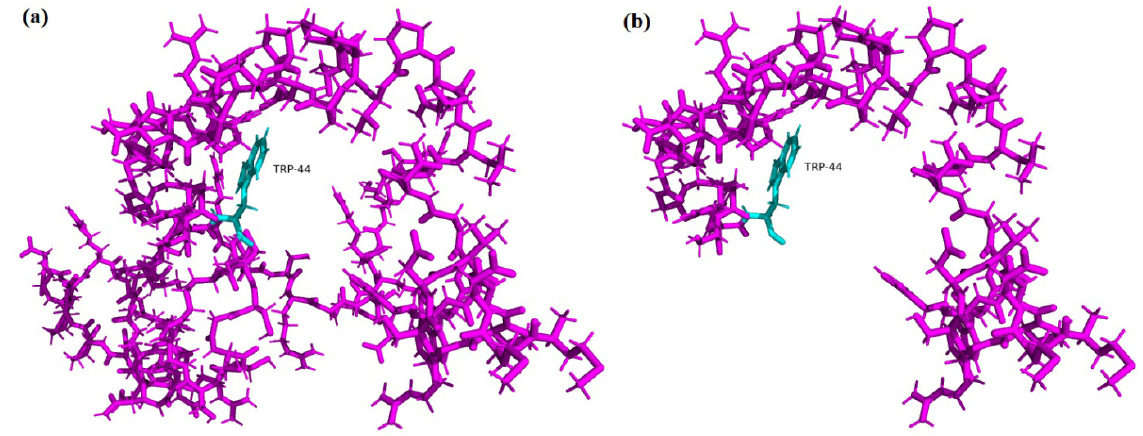
Figure 4. The 10Kda membrane anchorage region ( Met1 ‐ Arg92) represented in sticks. ( a ) The nor ‐ mal membrane anchorage region in magenta with Trp ‐ 44 in cyan; the site of nonsense mutation and ( b ) the mutant membrane anchorage region with the Trp ‐ 44 labelled.